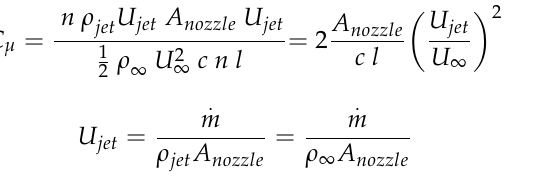
Figure 6. Grid system in internal and external domains ( α = 8° and δ f = 40°).